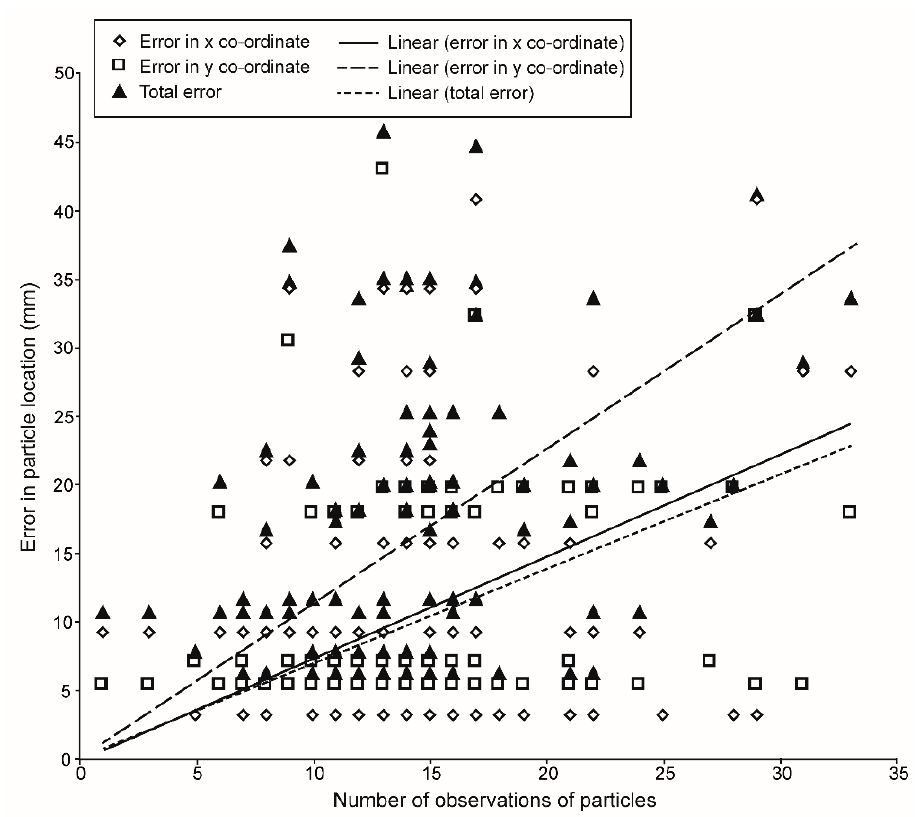
Figure 9. Regression of error in locating particles on the number of times it was detected showing error in (i) the x coordinate, (ii) the y coordinate, and (iii) total error. The sampling frequency affects the accuracy with which the RFID locations are detected. By removing alternate rows and columns in the grid used to site the reader (giving a sampling interval of 50 mm) the average error in locating the tagged particles is increased to 21.3 mm. However, the same weak (but statistically significant) positive relationship between the number of observations and the error in determining RFID locations is maintained.